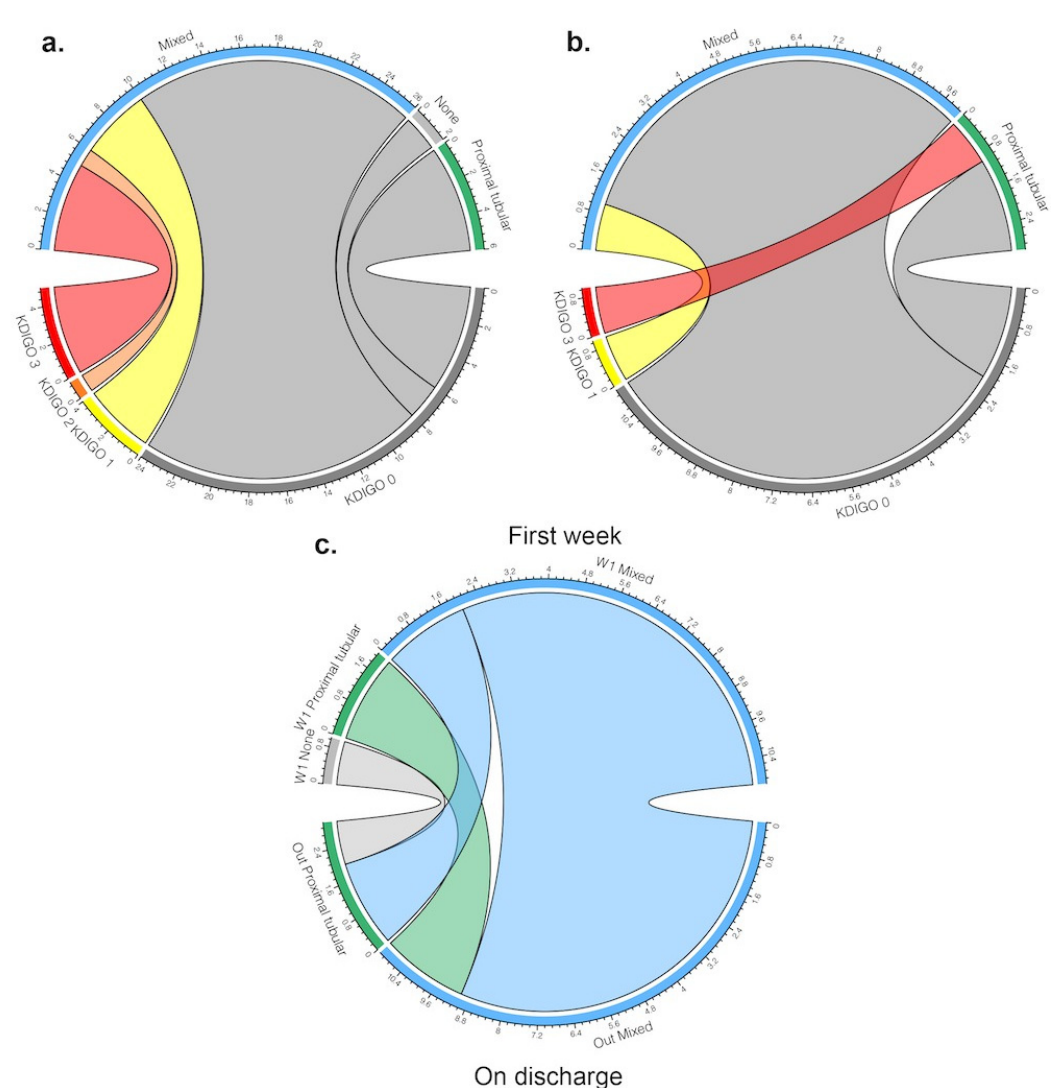
Figure 1. Chord diagrams representing characteristics of kidney injury during the ICU stay. ( a ) Relationship between kidney function estimated by the 2012 Kidney Disease: Improving Global Outcome (KDIGO) and intrinsic kidney injury within the first week after ICU admission; ( b ) Relationship between kidney function estimated by KDIGO and intrinsic kidney injury on ICU discharge; ( c ) Evolution of the intrinsic kidney injury between the first week after ICU admission and ICU discharge. The bottom part of the diagram represents patients sorted by their KDIGO classification, and the top part represents the same patients ranked according to the intrinsic kidney injury diagnosis made by profiling urinary analysis. Ribbons show for every patient the connection between kidney injury and function.